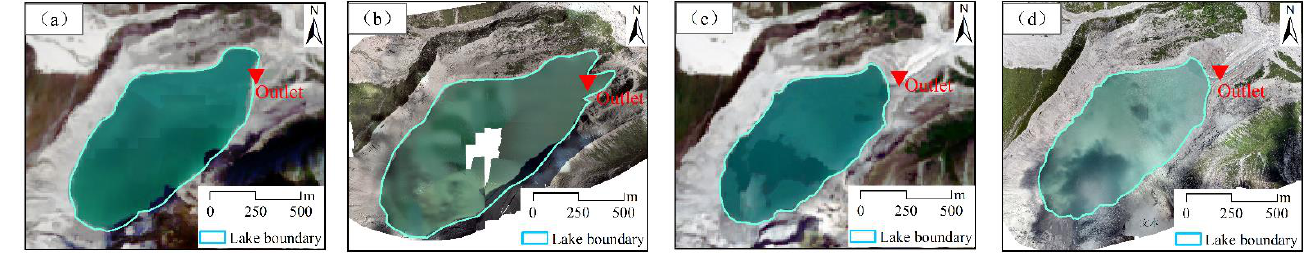
Figure 6. Comparison of Sentinel-2 MSI and UAV data accuracy. ( a ) Sentinel-2 16 July 2020. ( b ) UAV